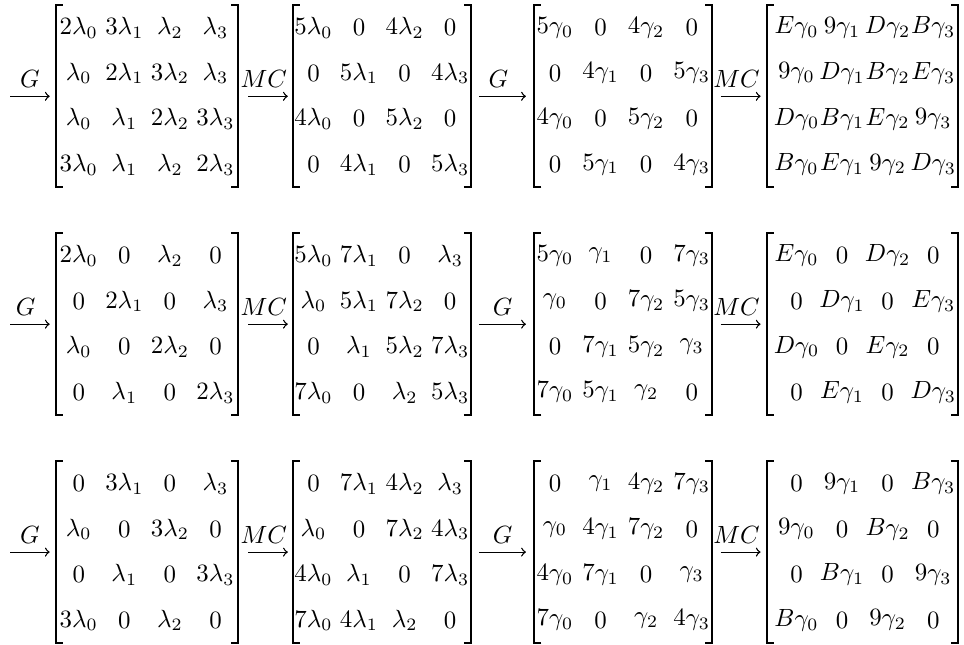
Figure 4: 4-round related differential trails starting with ∆ x , ∆ x 0 and ∆ x ⊕ ∆ x 0 respectively. Differences ∆ x , ∆ x 0 and ∆ x ⊕ ∆ x 0 are not shown here through the lack of